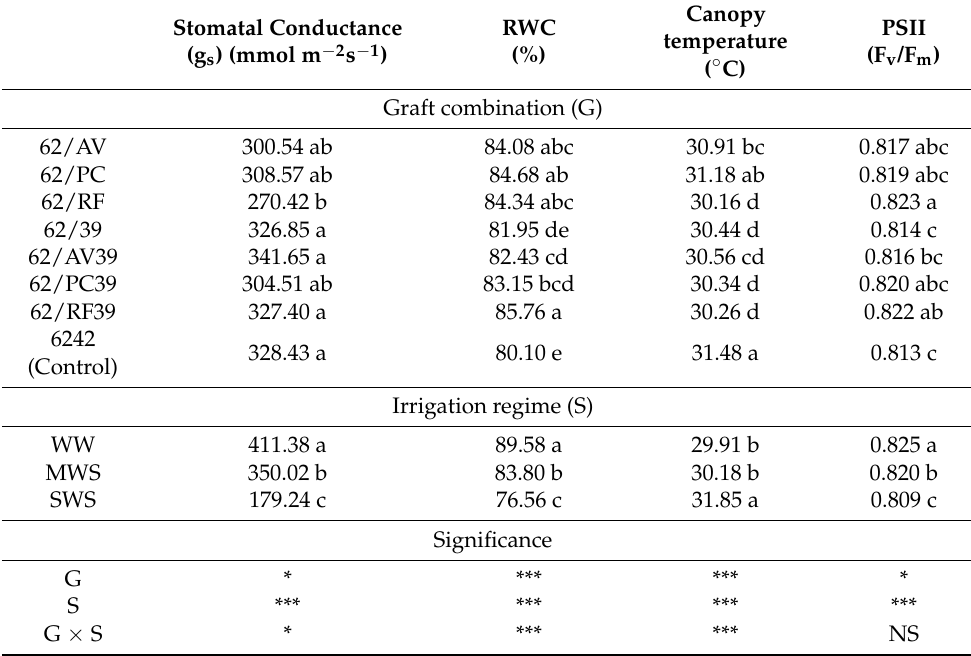
Table 2. Influence of grafting and water stress levels on stomatal conductance, leaf relative water content (RWC), canopy temperature and Fv/Fm.